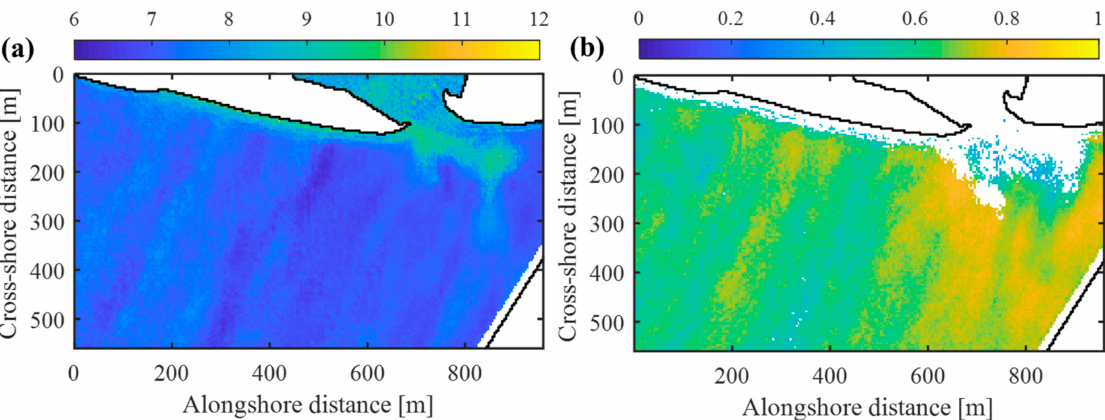
Figure 8. Spatial distributions of ( a ) the representative wave period and ( b ) the mean cross-correlation